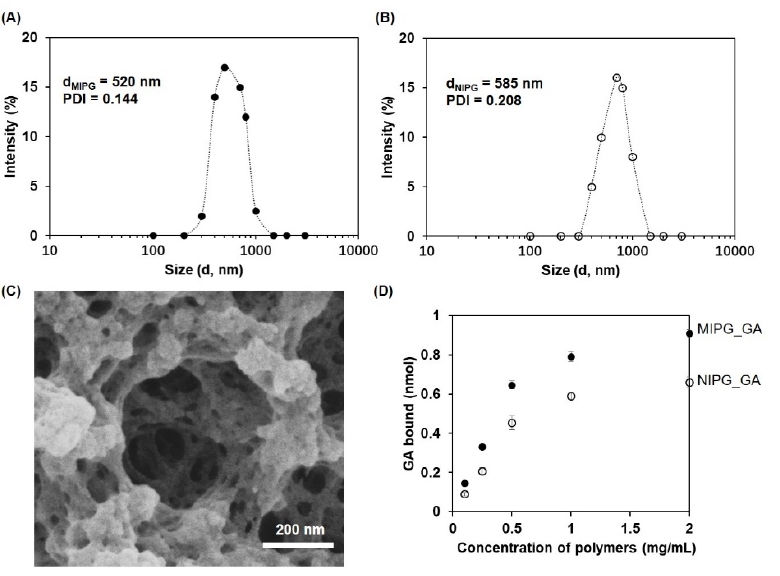
Figure 3. Dynamic light scattering measurements of 0.5 mg/mL ( A ) MIPG_GA and ( B ) NIPG_GA in H 2 O (mean value of two experiments). ( C ) SEM image of MIPG_GA. ( D ) Equilibrium binding isotherm for 1 mM GA on MIPG_GA and NIPG_GA at the concentrations ranging from 0.1 to 2 mg/mL in water. Data are means of three independent experiments. The error bars represent standard deviations.